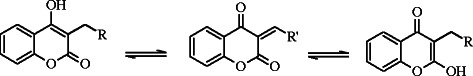
Tautomerism in coumarin structure.